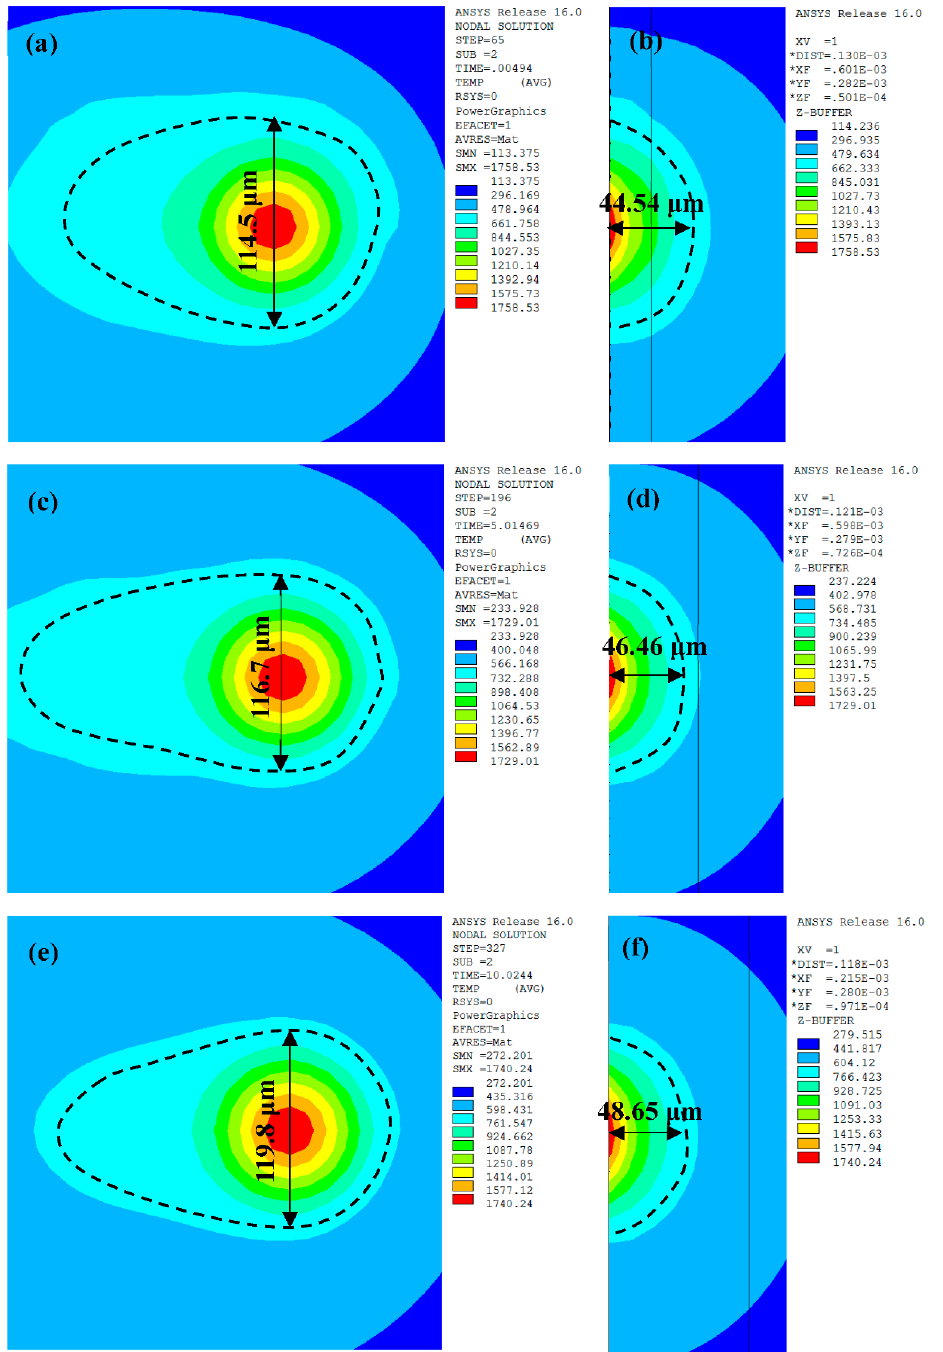
Figure 5. Temperature distributions of melt pool at Point 1 ( a , b ); Point 2 ( c , d ); and Point 3 ( e , f ) during SLM process at Exposure Time (ET) = 140 μs and Point Distance (PD) = 80 μm. The left is the top surface and the right is the cross-section.